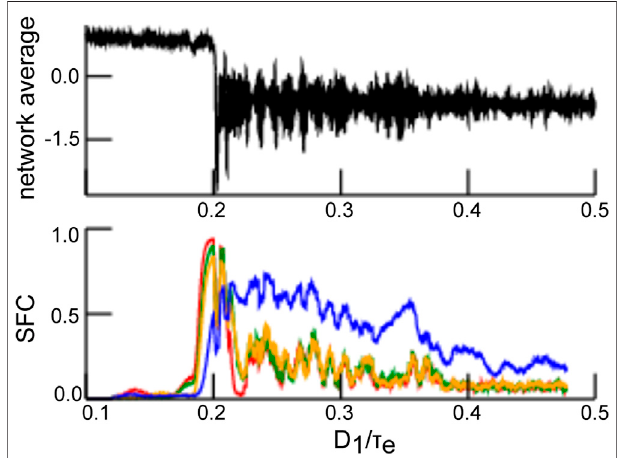
FIGURE1| Synchronizationdependentonnoiseintensityasamarkerof coherenceresonance.Thetoppanelshowsthenetworkaverageof V in Eq.1 and the bottom panel provides the Spike Field Coherence (SFC) in the Θ − (red), α − (green), β − (orange) and c − (blue) frequency range. For low noiseintensity D 1 / τ e thereisnoSFC,intermediate noiseintensityyieldsstrong SFC while large noise intensities diminish SFC again. To gain the SFC values, we have integrated in time the model system with 10 4 time steps while increasing the noise variance according to ( Eq. 7 ). For illustration reasons, the SFC-values have been averaged by a sliding window of length / τ ) (cid:1) 0 . 004. De fi nitions are given in section 2 and parameters are the Δ ( D 1 e same as in Figure 4 with q (cid:1)